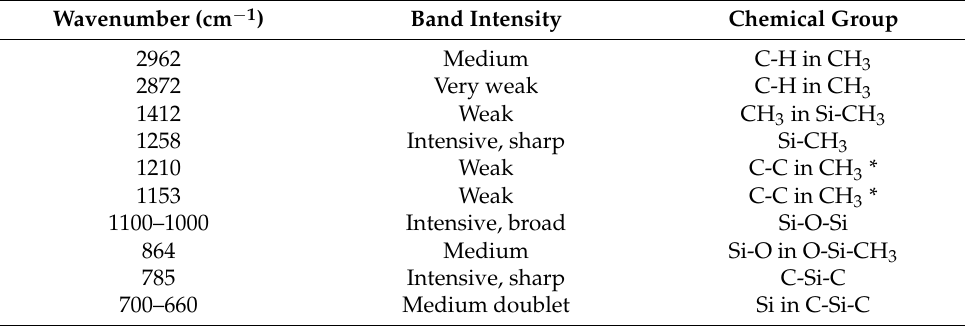
Table 6. Absorption bands characteristic for smooth and geometrised MVQ vulcanisates, before and after laser